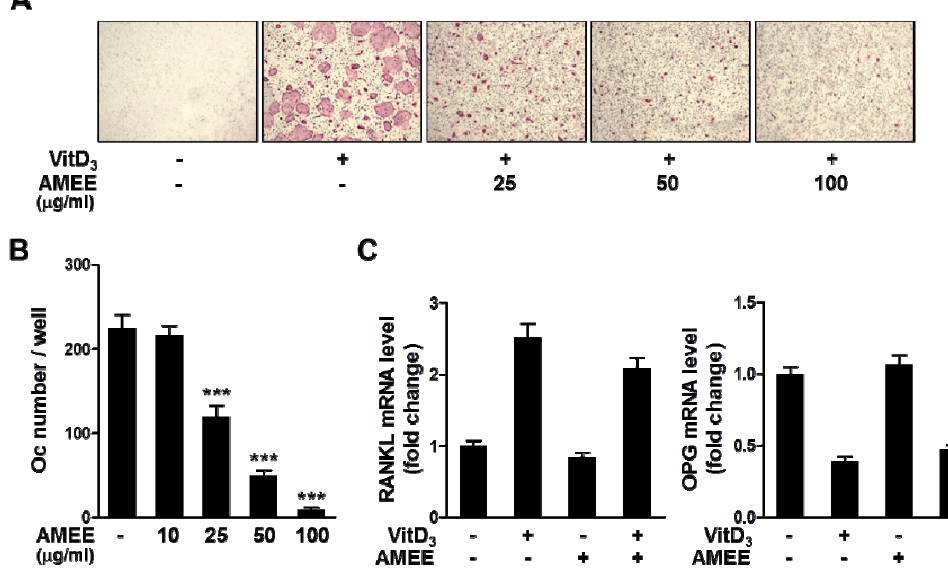
(10 nM) for 6 3 (10 nM) for 24 h. 3